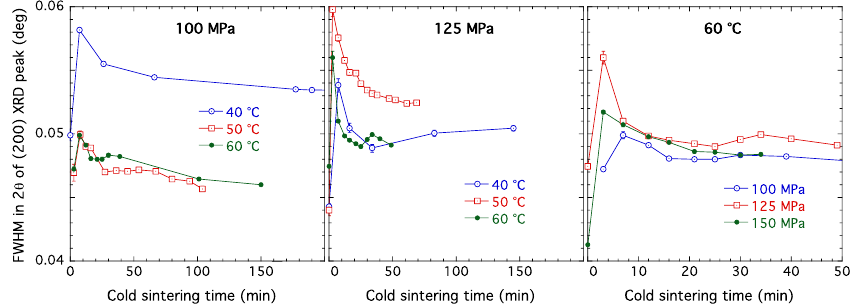
Figure 12. FWHM in 2θ of 200 XRD peak versus cold sintering time for 40 °C, 50 °C, 60 °C with p = 100 MPa and 125 MPa, and for p = 100 MPa, 125 MPa, 150 MPa at 60 °C. Lines are guide to the eye. Vertical bars represent the computed peak fitting standard uncertainties, and are mainly smaller than the data points, themselves.